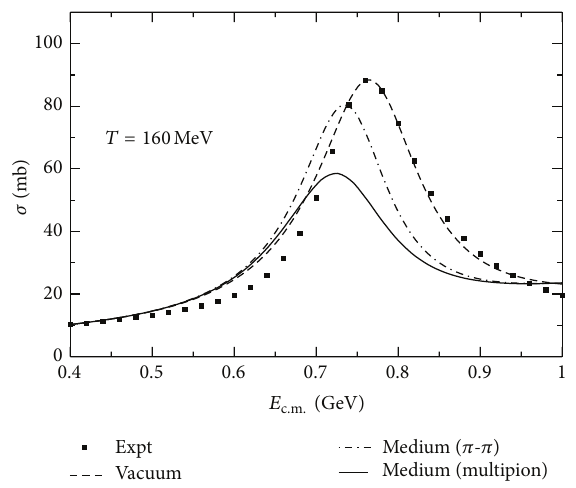
Figure 3: The 𝜋𝜋 cross-section as a function of centre of mass energy. The dotted line indicates the cross-section obtained using (109) which agrees well with the experimental values (106) shown by filled squares. The dashed and solid lines depict the in-medium cross-section for 𝜋𝜋 and 𝜋ℎ (ℎ = 𝜋,𝜔,ℎ 1 , 𝑎 1 ) loops, respectively, in the 𝜌 self-energy evaluated at 𝑇 = 160MeV.